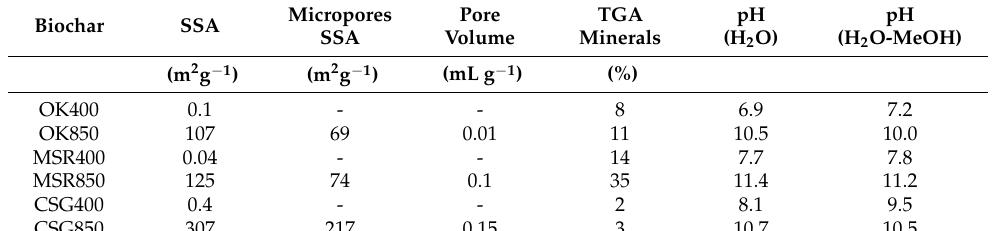
Figure 2. XRD patterns of the prepared biochars: ( a ) OK400 and OK850, ( b ) MSR400 and MSR850, ( c ) CSG400 and CSG850.